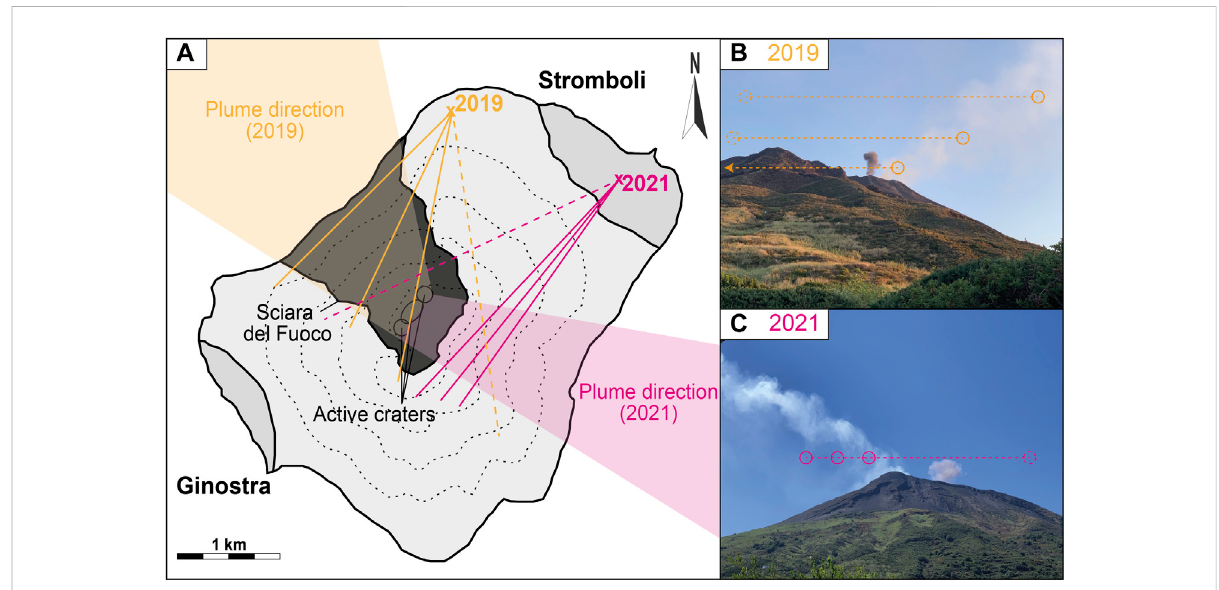
FIGURE 1 (A) Sketch map of the island of Stromboli, depicting the measurement locations and approximate plume geometries during the two measurementcampaigns[2019inyellow,2021inmagenta].Greyshadedareas(labeledStromboliandGinostra)representsettlementsontheisland. The black shaded area represents the collapse feature known as the Sciara del Fuoco . The approximate location of the three main crater areas (Northeast, Central and Southwest) is indicated by ellipses. Shaded coloured polygons represent the general plume direction during measurements. Coloured lines represent the range of azimuths during plume (solid) and clear sky (dashed) measurements (B and C) Photographs taken from the measurement location in the 2019 (B) and 2021 (C) campaigns. Circles represent the approximate location of the instrument fi eld of view during plume (solid) and clear sky (dashed)